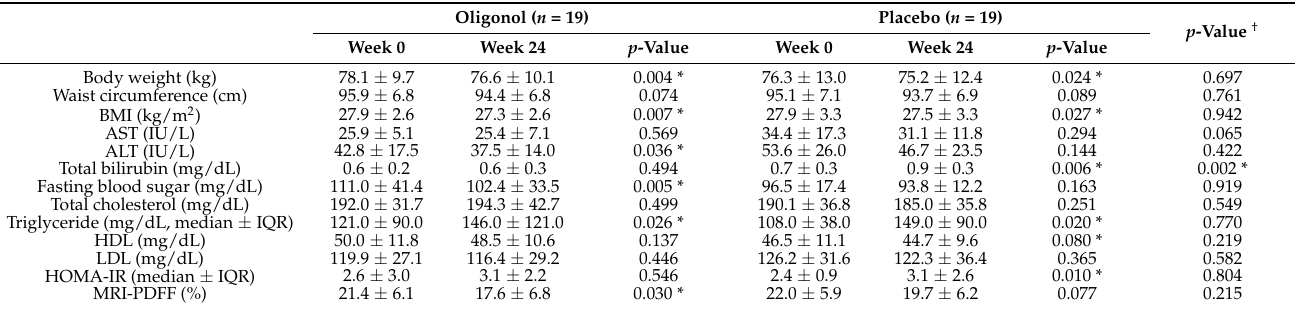
Table 2. Clinical data of patients with NAFLD in the oligonol and placebo groups at week 0 and week